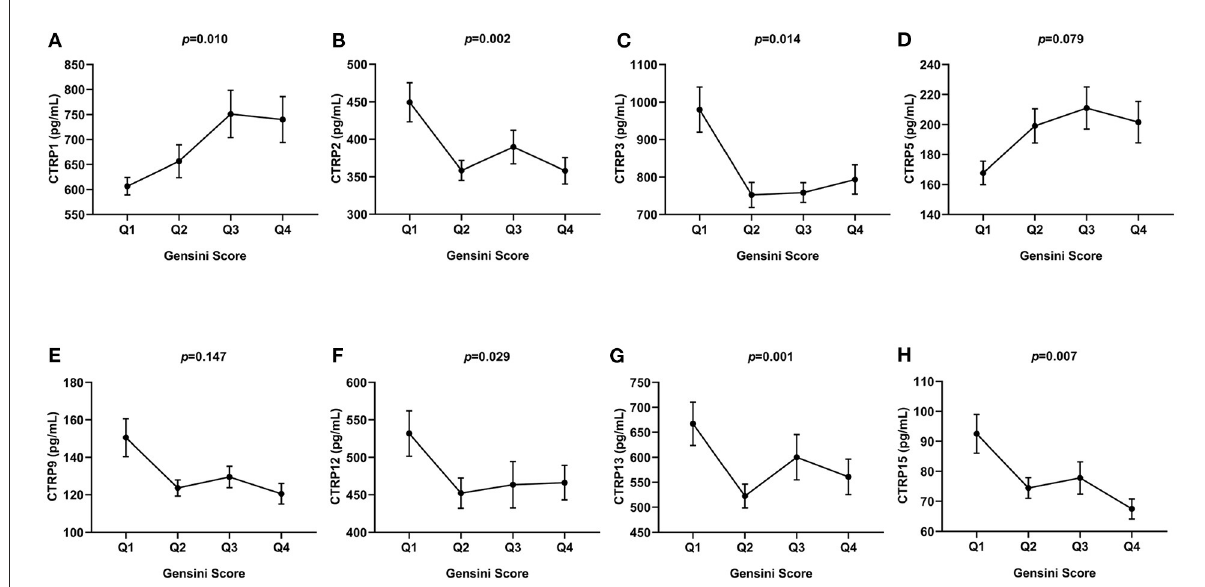
FIGURE4 Comparison of serum CTRP family levels between different groups according to Gensini score quartiles. (A) CTRP1, (B) CTRP2, (C) CTRP3, (D) CTRP5, (E) CTRP9, (F) CTRP12, (G) CTRP13, and (H) CTRP15. Data are mean ± standard error of the mean